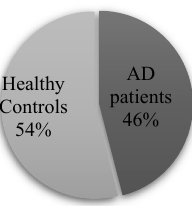
Figure 3. Distribution of the population by clinical condition (healthy/pathological).